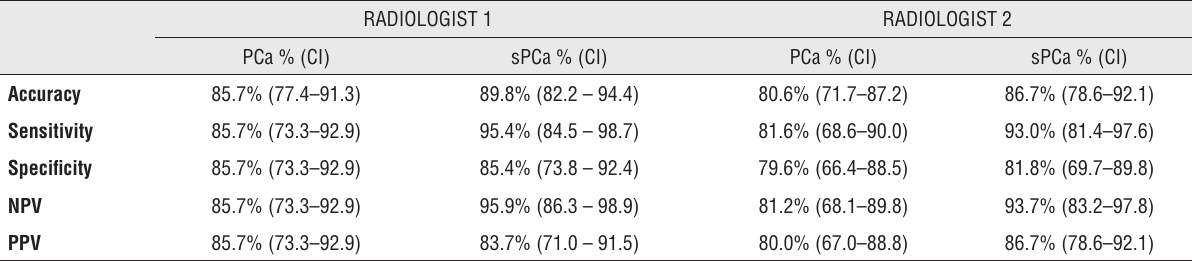
Table 5 - Accuracies, sensitivities, specificities, negative predictive values, and positive predictive values of PI-RADSv2 for the diagnosis of PCa and SPCa.